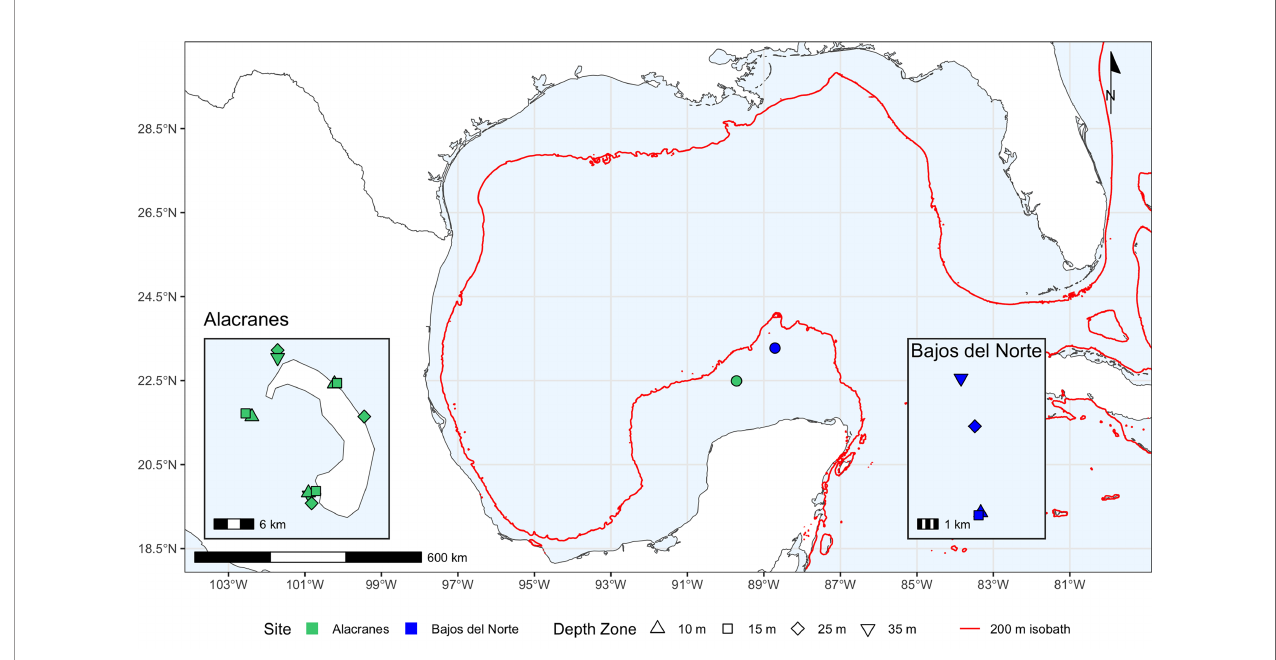
FIGURE 1 | Coral sampling sites at Alacranes and Bajos del Norte with shape indicating the depth zone of samples collected at that location. The red line on the main map indicates the 200 m isobath which approximates the continental shelf